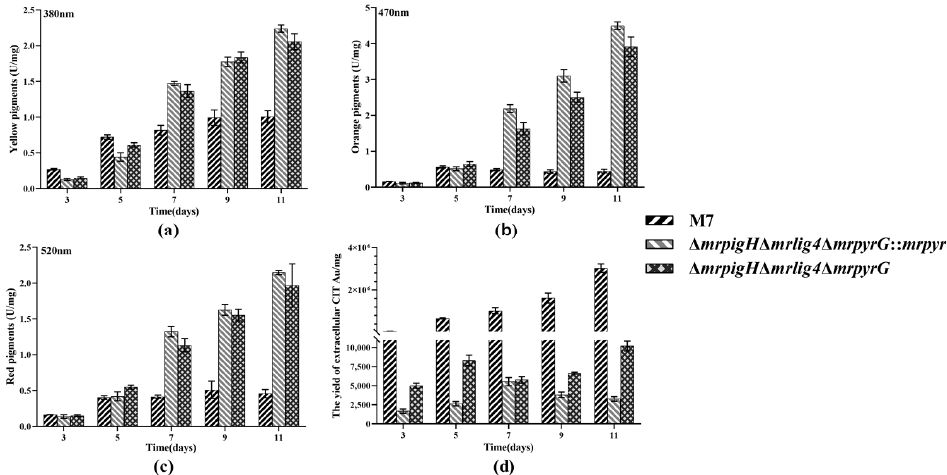
Figure 3. Production of intracellular MPs and extracellular CIT by M. ruber M7 and mrpigH mutants on the PDA supplied with/without uridine. ( a ) The yield of yellow pigments; ( b ) The yield of orange pigments; ( c ) The yield of red pigments; ( d ) The yield of CIT. The error bar represents the standard deviation between the three repeats.